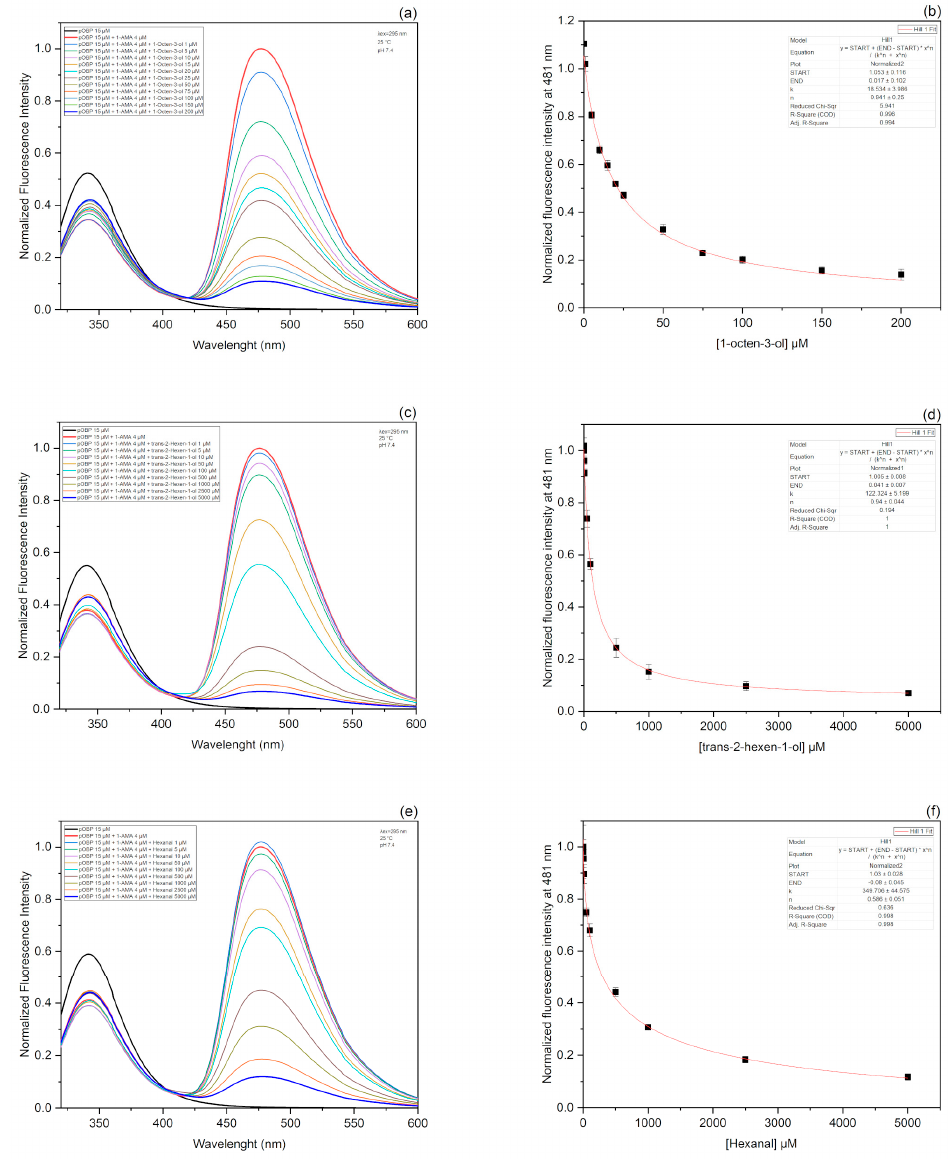
Figure 4. Fluorescence emission spectra and titration curves fitting of 1-octen-3-ol, trans-2-hexen-1-ol, and hexanal. Emission fluorescence spectra of pOBP were acquired in the presence of saturating concentrations of 1-AMA. The addition of increasing amounts of 1-octen-ol ( a ), trans-2-hexen-1-ol ( c